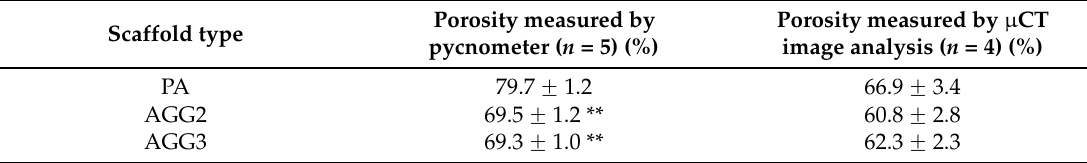
(** p < 0.005) difference between values of PA compared to AGG2 and AGG3.